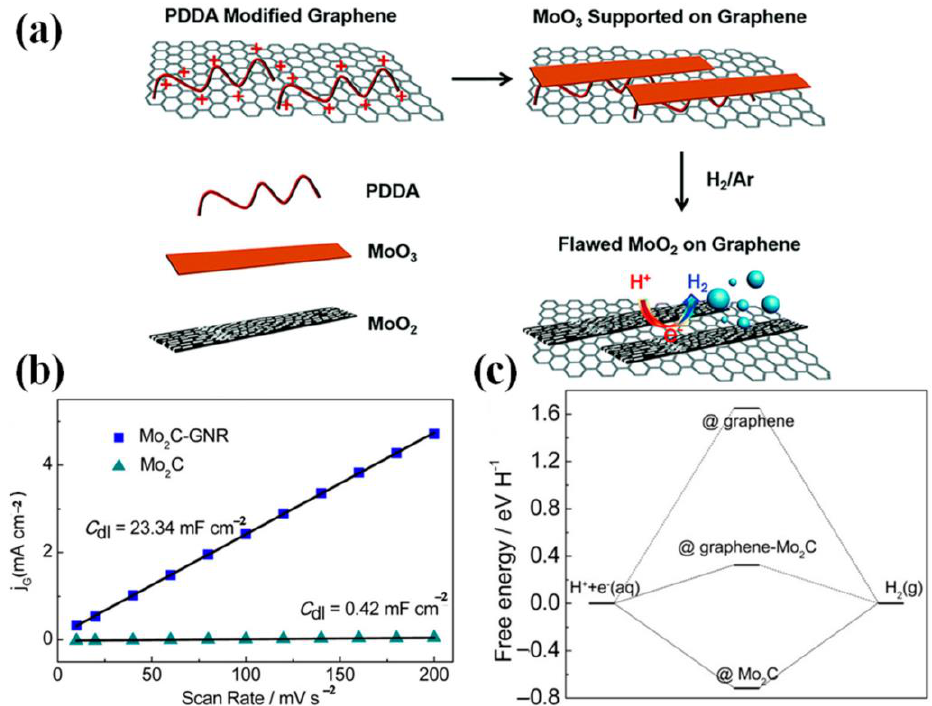
Figure 3. ( a ) Preparation scheme of the MoO 2 on graphene. Reproduced with permission from [34]. Copyright 2015, The Royal Society of Chemistry. ( b ) Current density plotted against scan rate. ( c ) Free energy evolution of H, against standard hydrogen electrode (SHE). Reproduced with permission from [61]. Copyright 2017, American Chemical Society.